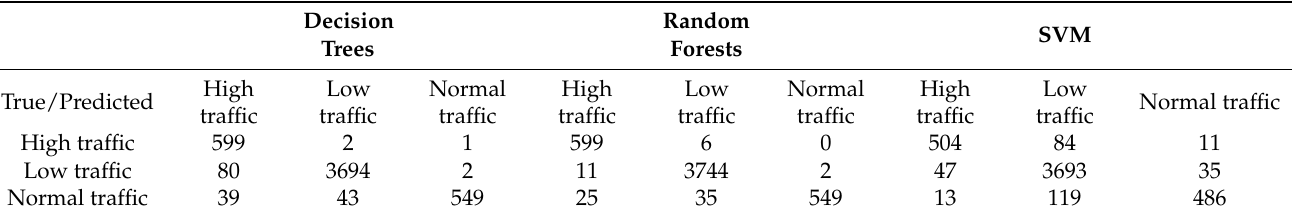
Table 6. Confusion matrix for road traffic conditions